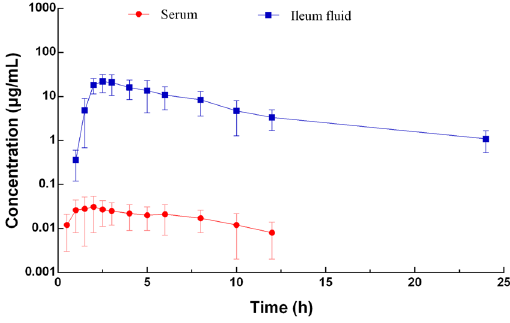
Figure 5. Concentration vs. time curve of cyadox in plasma and ileum fluid of pigs (Mean ± SD, n = 6).